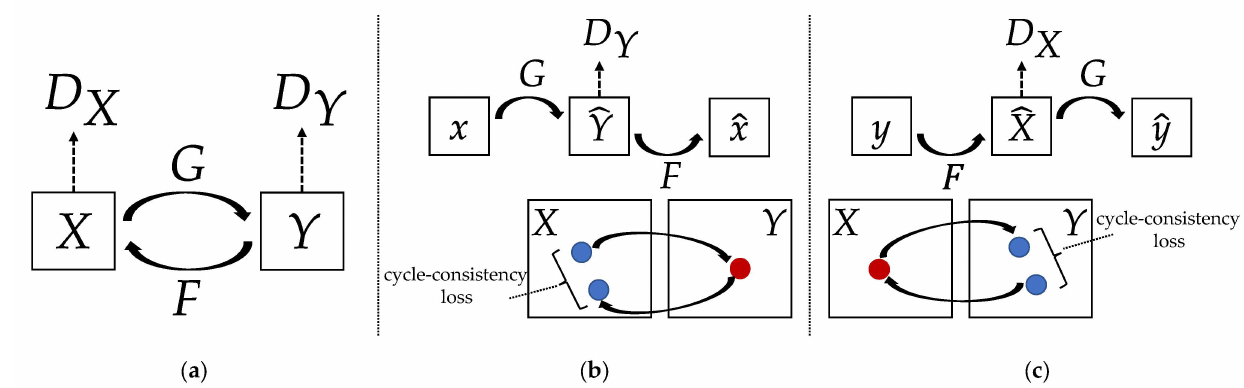
Figure 2. ( a ) The CycleGAN process for mapping and discriminating between two domains. ( b ) The forward cycle consistency process. ( c ) The backward cycle consistency